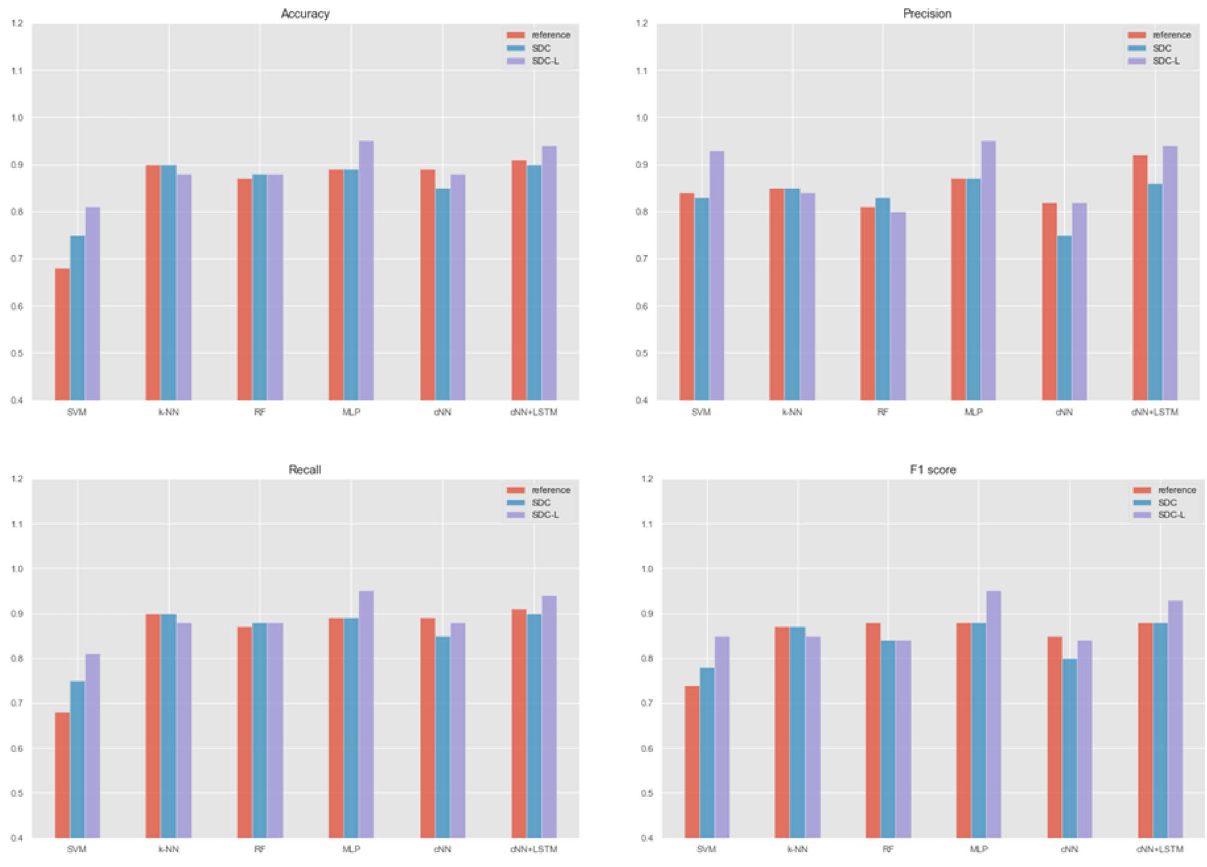
Figure 3. Performance comparison (MFCC vs. SDC vs.